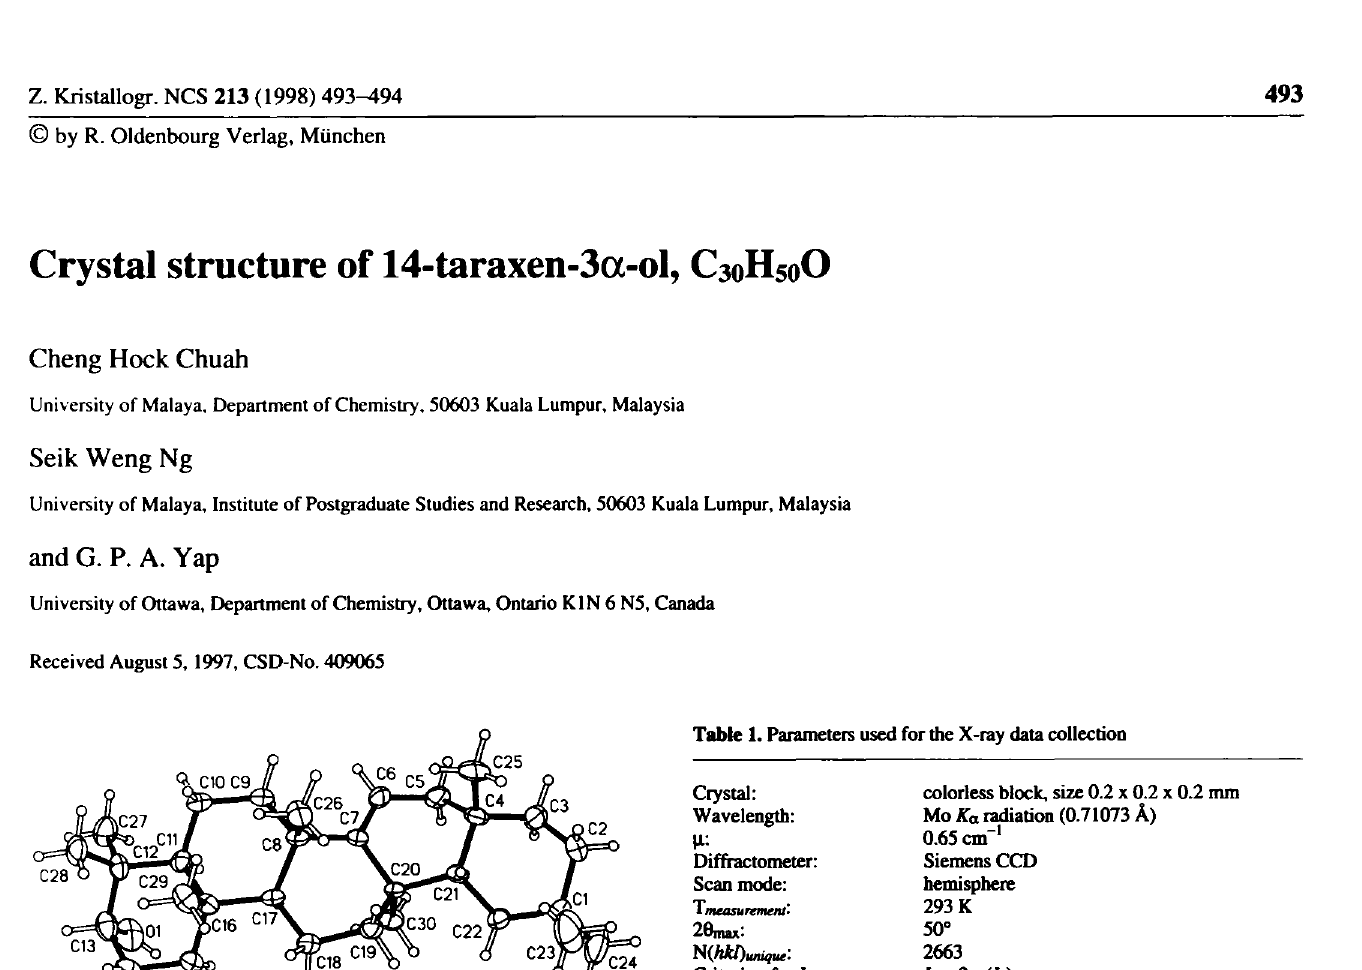
Table 2. Final atomic coordinates and displacement parameters (in Â^)